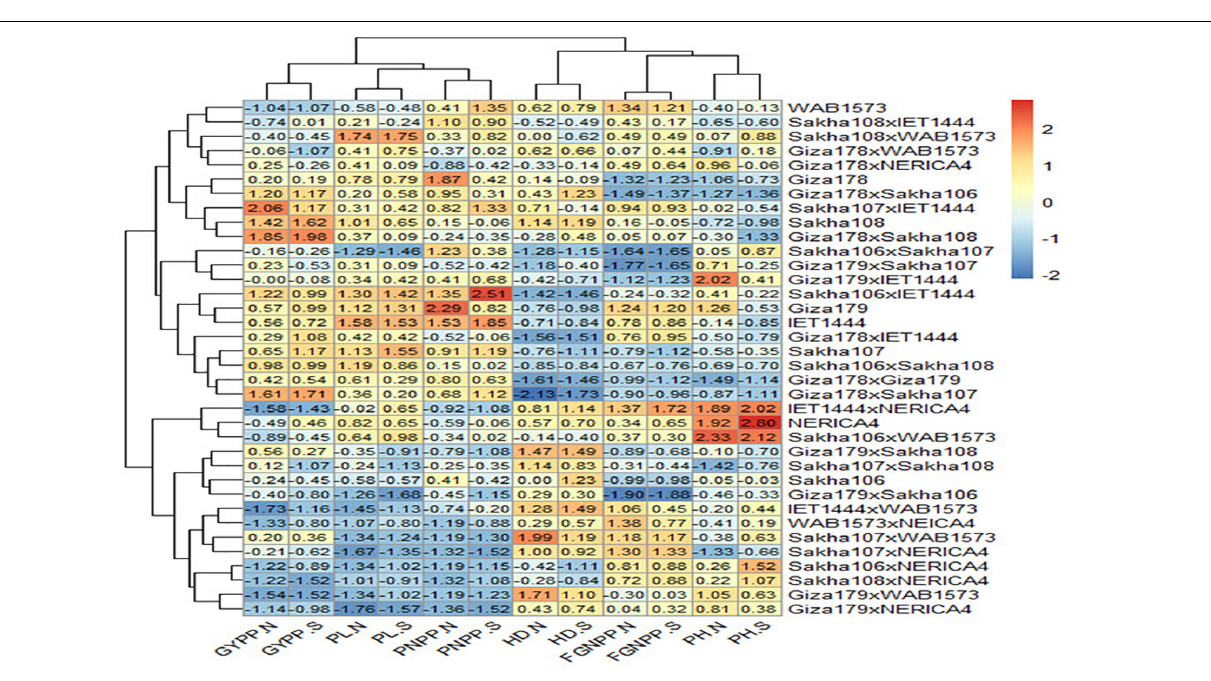
Frontiers in Plant Science |